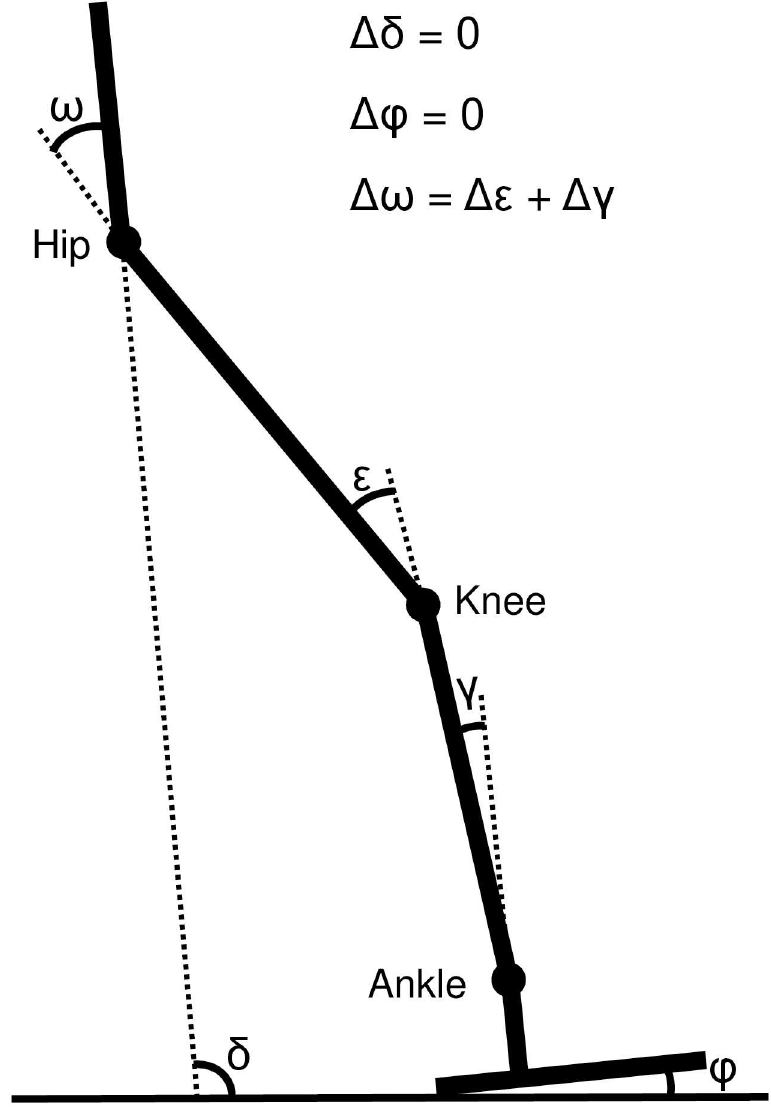
Fig 4. The pelvic tilt ( δ ) and foot angle ( φ ) are not affected by postural changes of the hip ( ω ), knee ( ε ), and ankle ( γ ) in the present model.